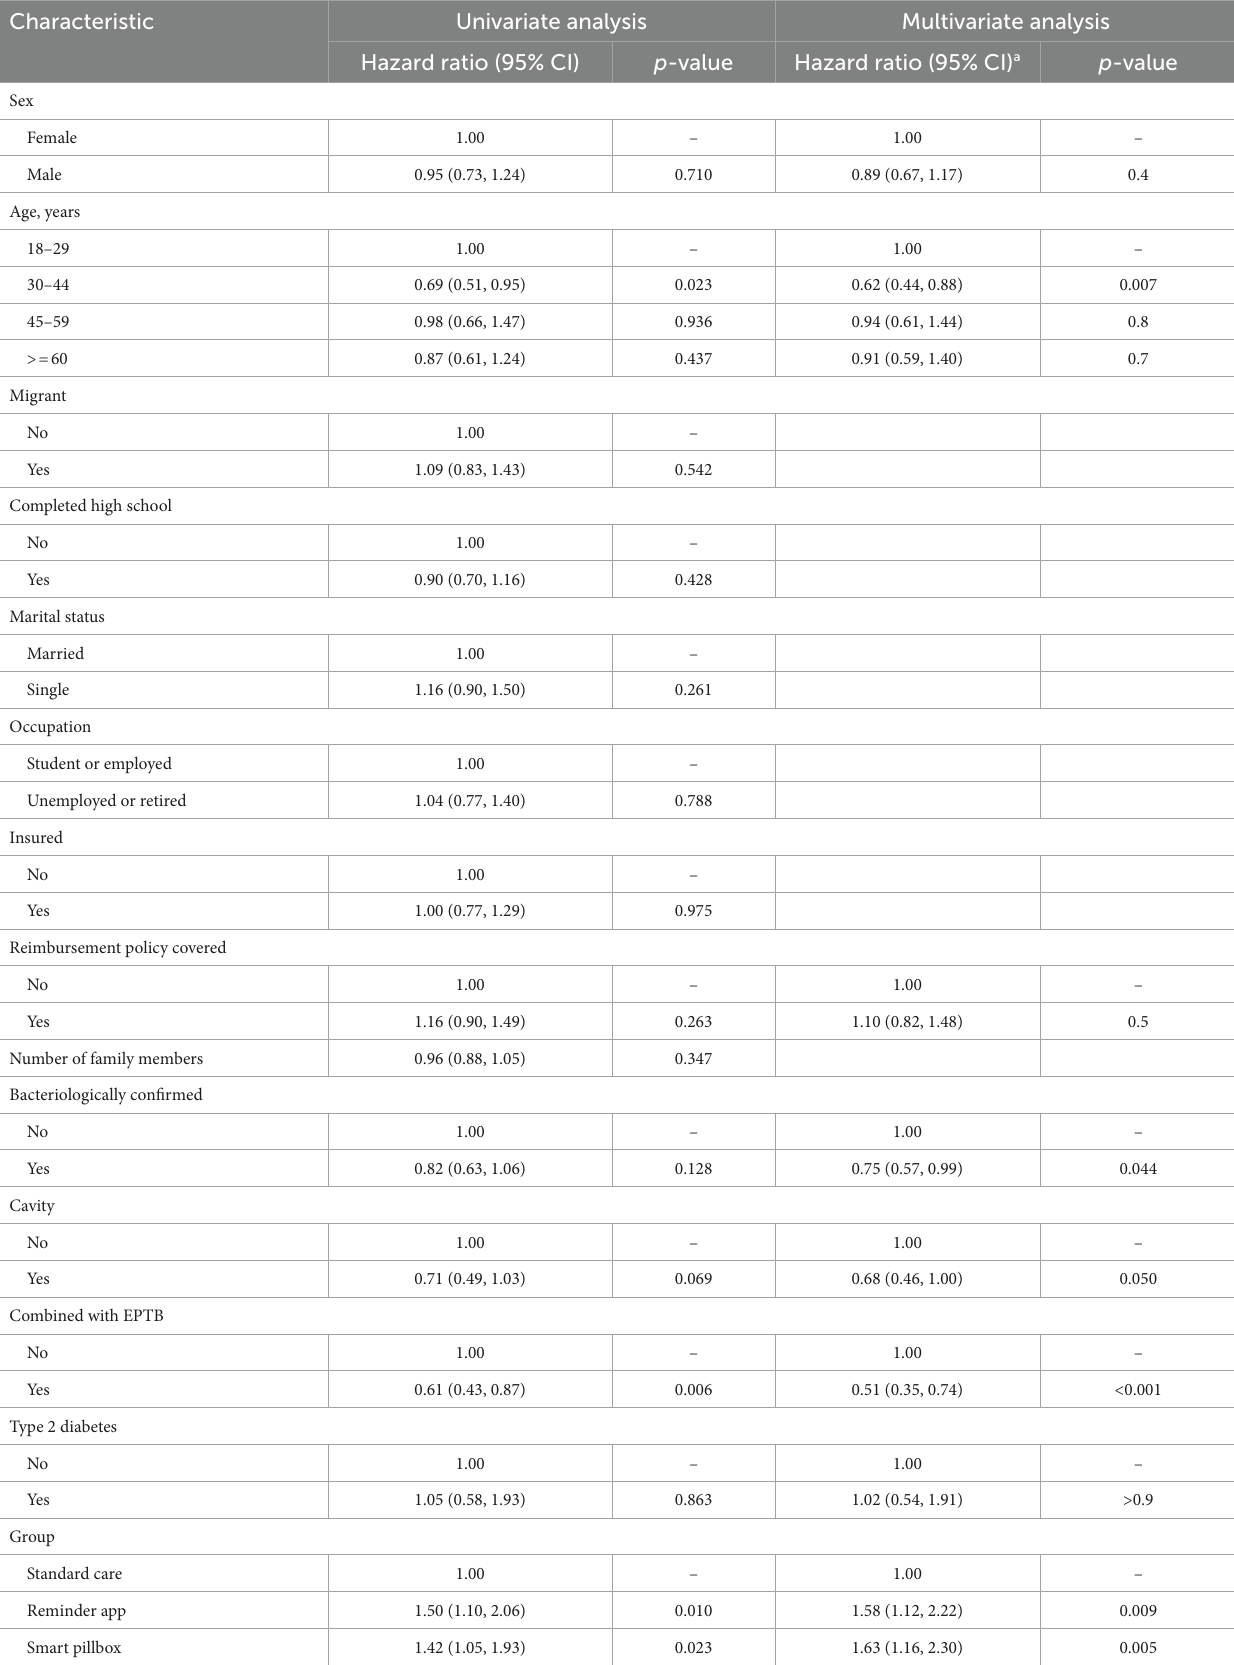
TABLE 3 Univariate and multivariate analysis of factors associated with treatment success. Characteristic Univariate analysis Multivariate